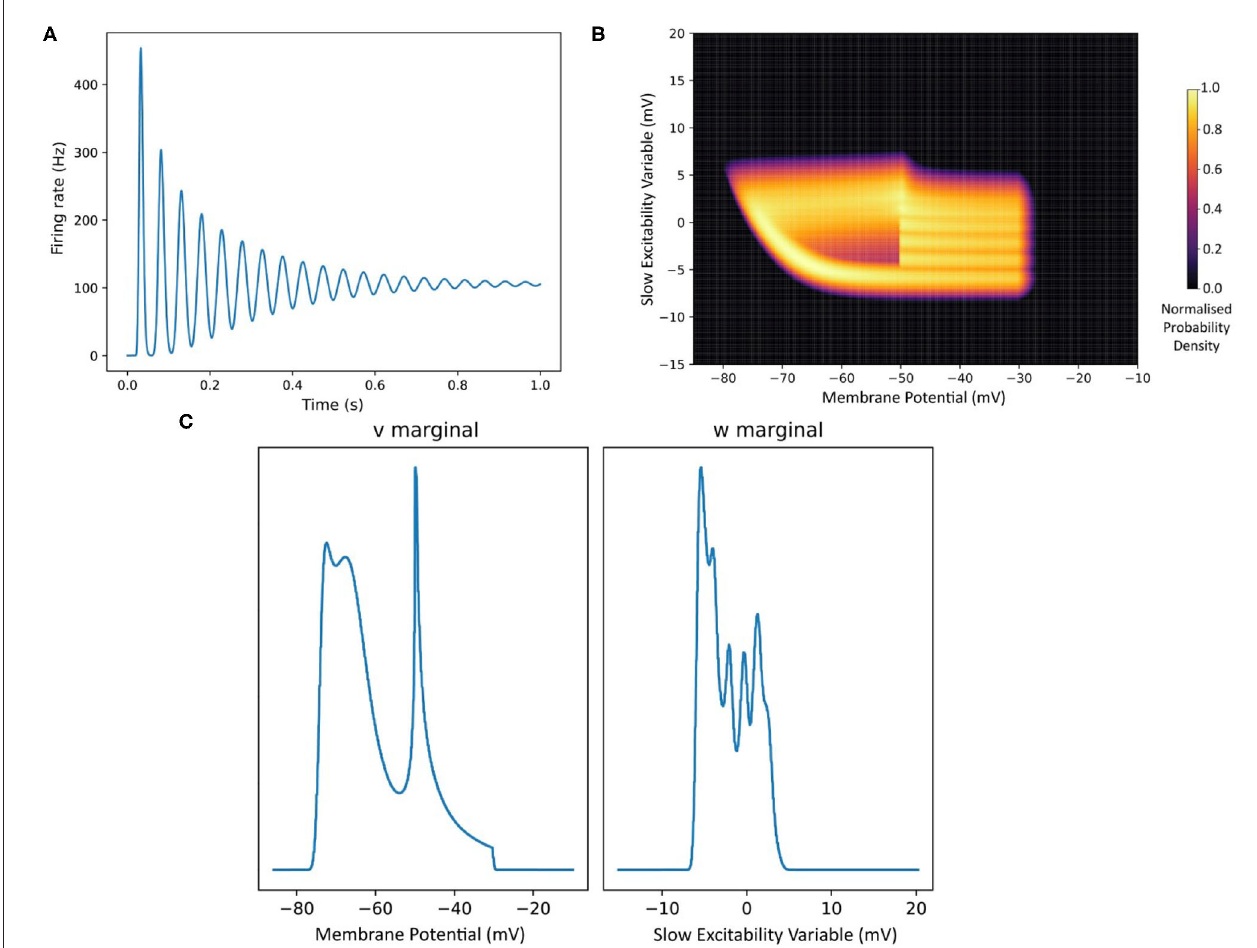
FIGURE 11 | (A) The average firing rate of a population produced by calling the rate command. (B) A density plot (normalised to the maximum density value) of the population produced by calling the plot-density command. (C) The marginal density plots produced by calling the plot-marginals